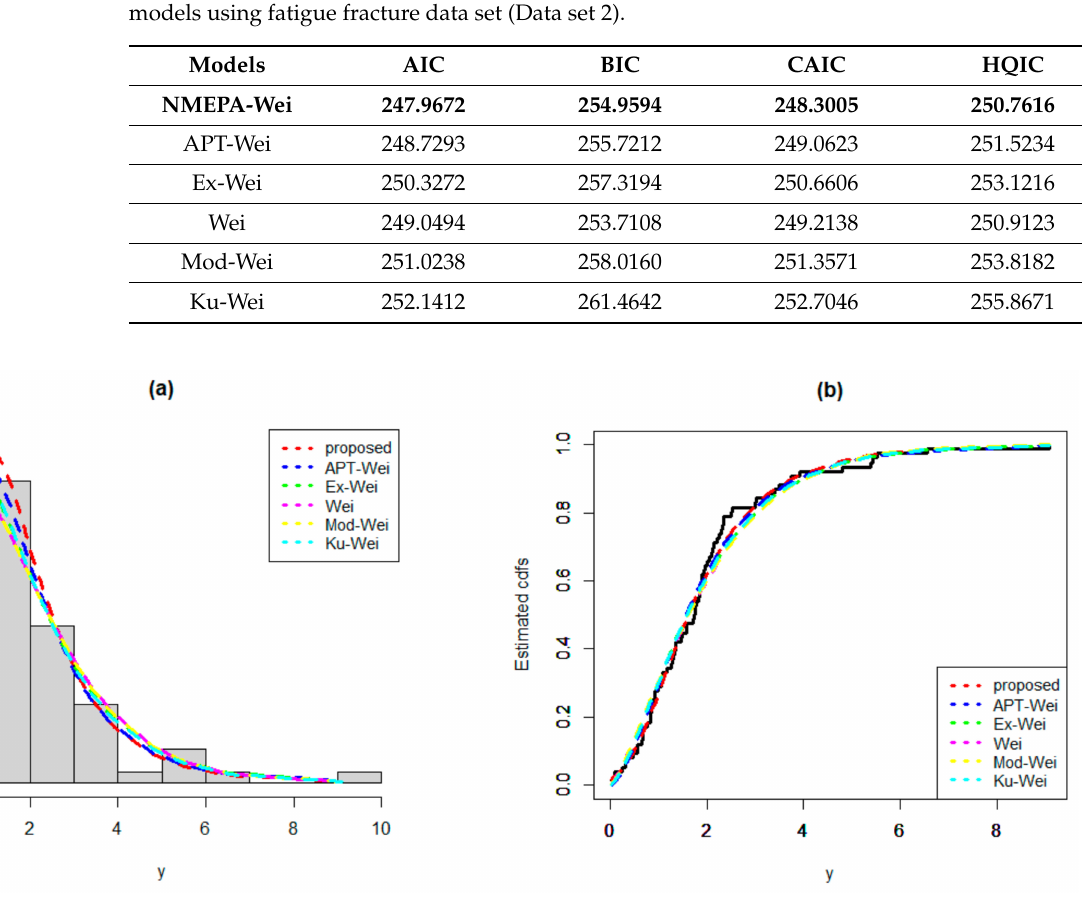
Figure 16. Plots of ( a ) estimated PDFs, and ( b ) estimated CDFs of competitive models for Data